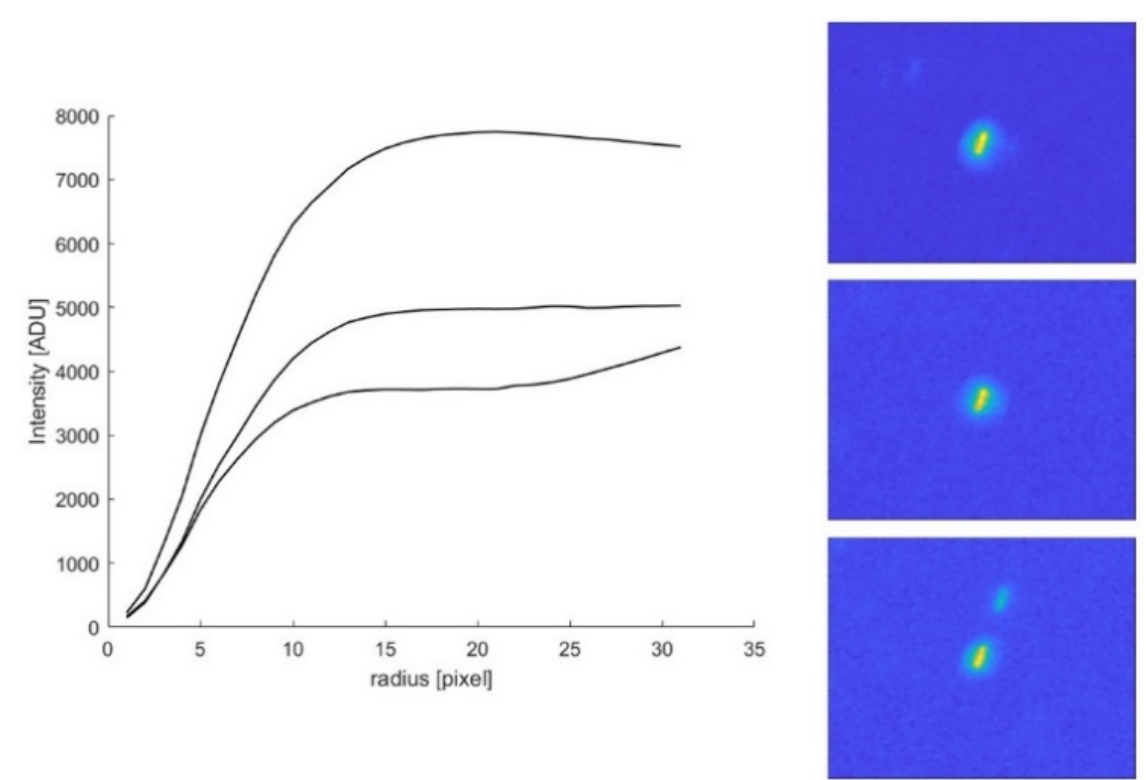
Figure 2. Intensity variation with respect to the radius ( growth curves) for 3 different stars. The upper curve corresponds to the upper image, the central curve (the only asymptotic stable curve) corresponds to the central image and the lower curve corresponds to the lower image.